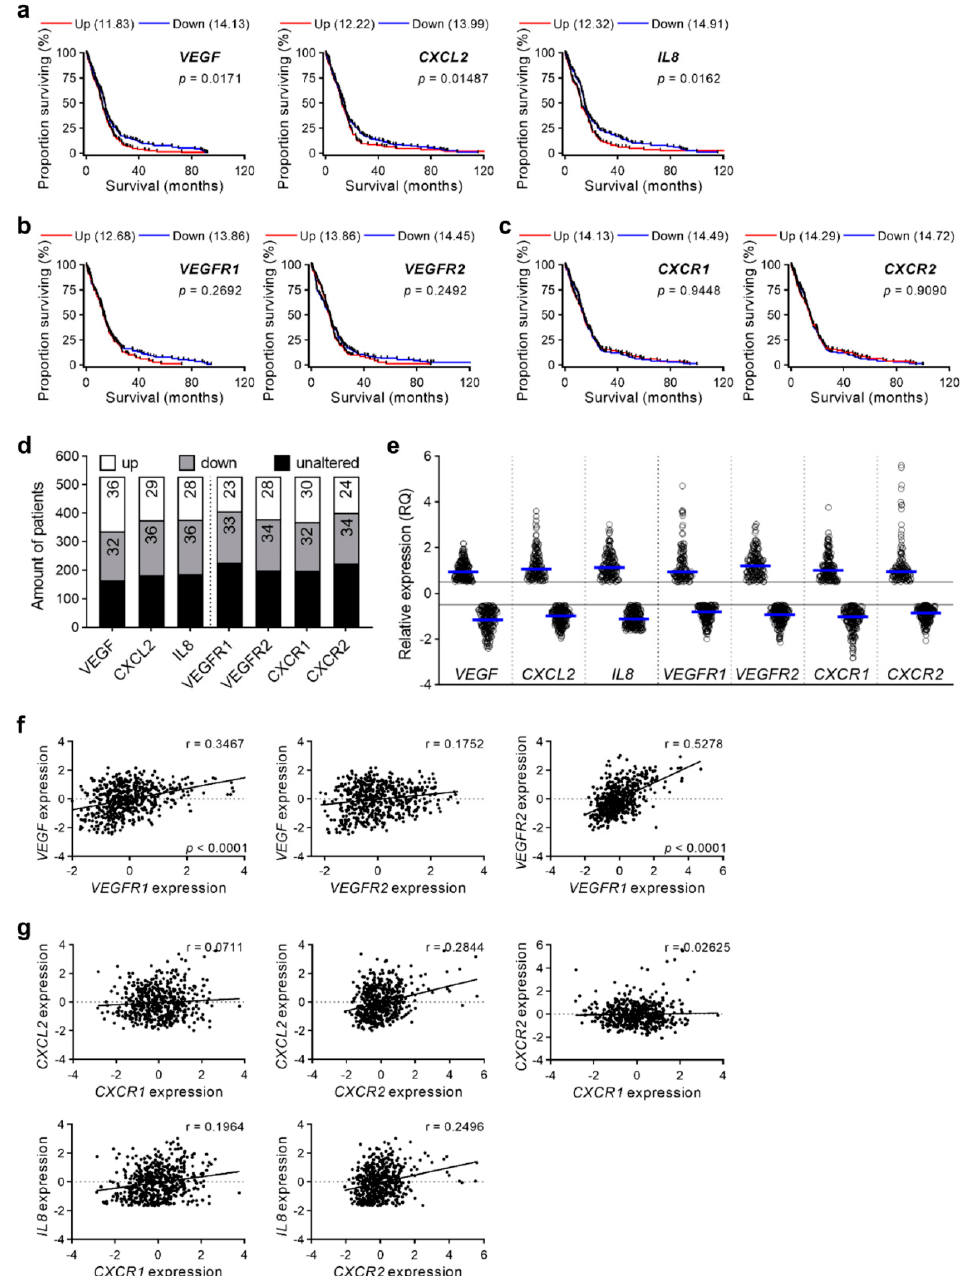
Figure 2. TCGA database analyses related to proangiogenic factors and their respective receptors. ( a – c ) TCGA database was used to prepare survival curves of GBM patients concerning proangiogenic factors VEGF, CXCL2 and IL8 ( a ), and the receptors VEGFR1 , VEGFR2 ( b ) as well as CXCR1 and CXCR2 ( c ). Patients were clustered in groups with upregulation (Up, z-score > +0.5) and downregulation (Down, z-score < -0.5) of molecules. VEGF (Up: n = 166, Down: n = 151), CXCL2 (Up: n = 134, Down: n = 169), IL8 (Up: n = 133, Down: n = 160), VEGFR1 (Up: n = 99, Down: n = 160), VEGFR2 (Up: n = 121, Down: n = 156), CXCR1 (Up: n = 122, Down: n = 152), CXCR2 (Up: n = 113, Down: n = 153). Median survival (months) of groups as well as p-values are indicated. Log-rank (Mantel-Cox) test. ( d , e ) Expression data of GBM patients regarding proangiogenic molecules and their receptors from the TCGA database were analyzed. Percentage of patients with unaltered, upregulated, and downregulated molecule and receptor expression were calculated ( d ). Graph represents relative expression of analyzed genes. blue line: mean value of up- and downregulated samples, each dot illustrate one patient sample ( e ). z-score ± 0.5, n = 528. ( f , g ) Correlation of molecule and the respective receptor expression was analyzed. VEGF related genes ( f ) and CXCR2 pathway molecules ( g ) were correlated. Linear regression analyses were performed (Spearman correlation). r and significant p values are indicated; p ≤ 0.05 was considered statistically significant. n =